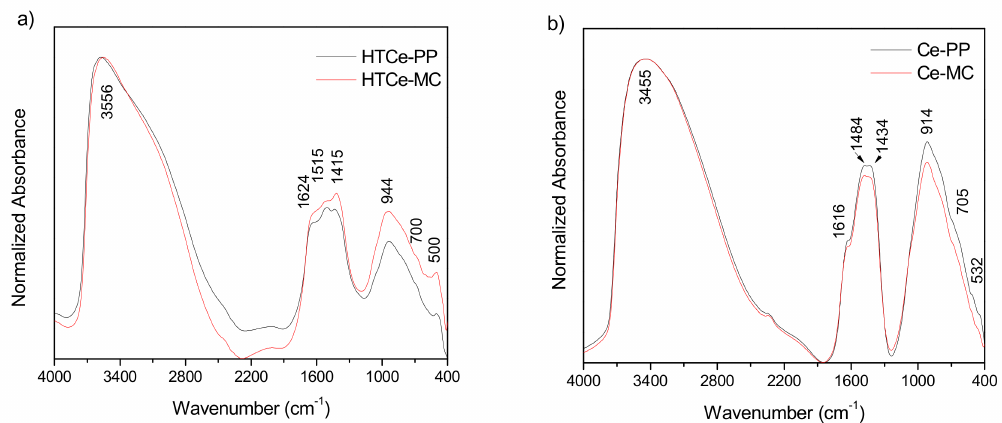
Figure 3. DRIFT spectra of the LDHs modified with cerium: ( a ) dried forms (HTCe-PP and HTCe-MC) and ( b ) calcined forms (Ce-PP and